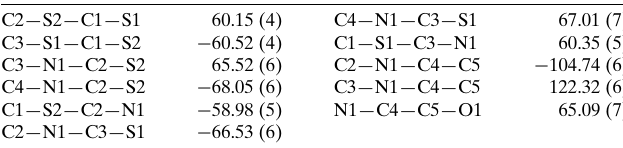
Table 1 Selected torsion angles ( (cid:3) ) for the 150 K structure.